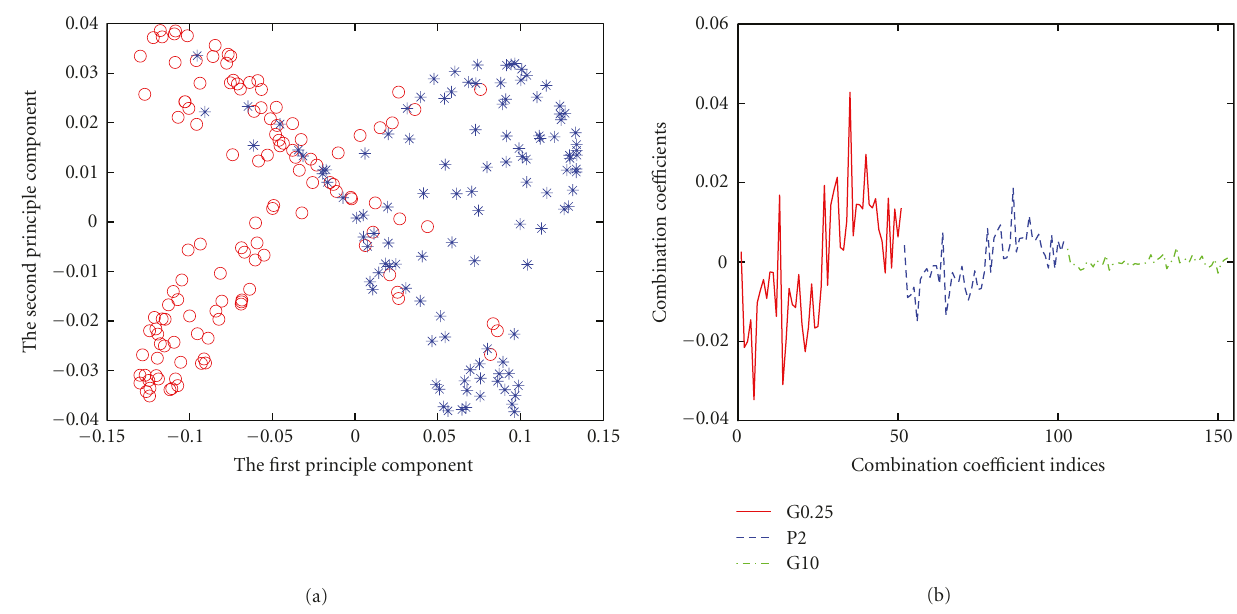
Figure 2: The results of Ripley’s data after FKO. (a) Two-dimensional projection of the training data in the optimized feature space. (b) the combination coe ffi cients α fusion